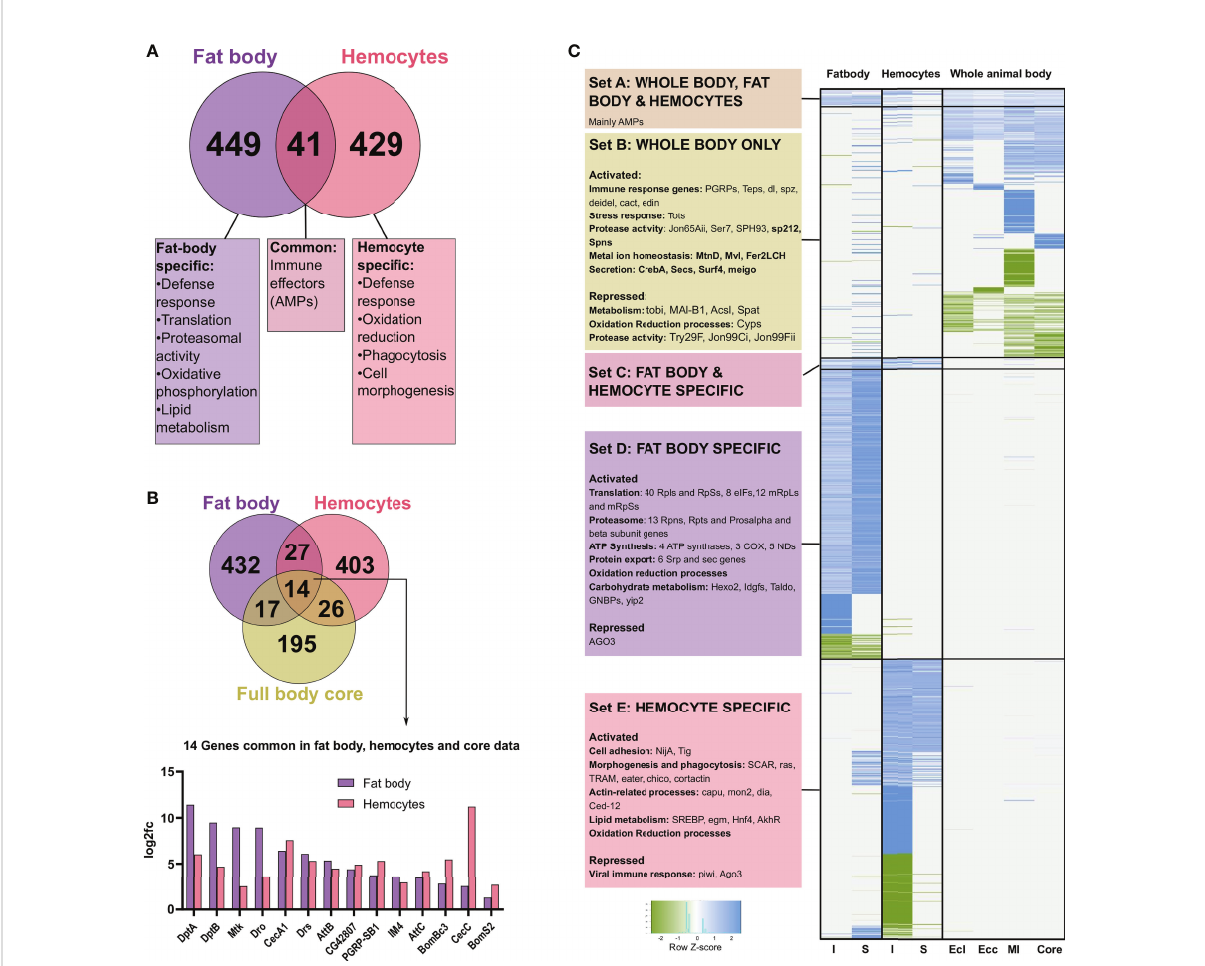
FIGURE 6 Comparison of the genes differentially expressed after infection and sterile injury, in fat bodies, hemocytes, and whole body data sets. (A) The number of commonly regulated genes in fat bodies and hemocytes on bacterial infection is shown with a summary of the common and distinct processes activated in each cell type. (B) Venn diagram showing the number of commonly regulated genes in bacteria infected fat bodies, hemocytes, and the ‘ core ’ from full body data (). The 14 genes commonly regulated in all three are shown at the bottom with the log 2 fold changes in the expression in fat bodies and hemocytes. Most of these common genes are AMPs. (C) Heatmap showing the clustering of expression data from I and S fat body and hemocytes and the whole-body data for E coli (Ecl), Ecc15 (Ecc), M. luteus (Ml), and the core. K- means clustering was performed on the genes differentially expressed in bacteria infected fat bodies, hemocytes, and full body data from Ecl, Ecc, Ml, and core based on the absence or presence of regulation of a gene. The scaled values for the log 2 fold change are plotted here for the different clusters. The data was further divided into biologically relevant sets of clusters. Set A consists of genes differentially expressed in all the treatments and consisted mainly of AMPs, while Set C is only differentially expressed in fat bodies and hemocytes. Set B, D, and E are the sample-type speci fi c clusters for whole body, fat body, and hemocytes respectively with some relevant categories and example genes shown for each